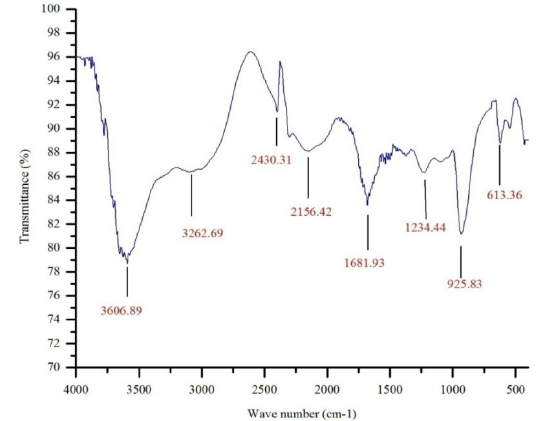
Fig. 11. Dielectric potential exists at the boundary of a SNP (Ztasizernano user manual, 2013; Haider and Kang, 2015)